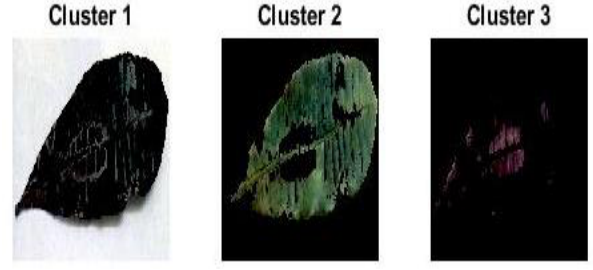
Figure 8 . Cluster size 3 and 60°co-occurrence angle